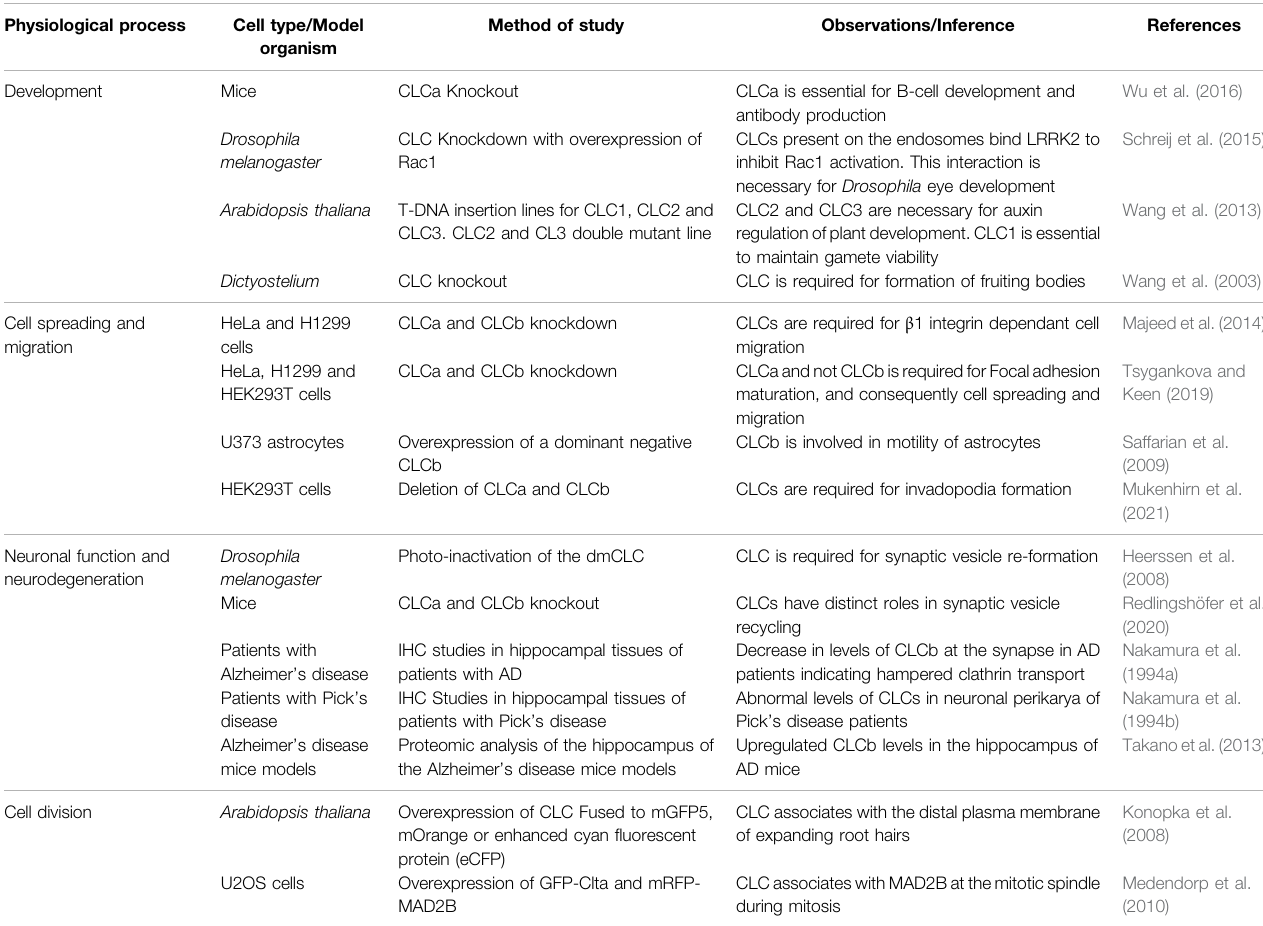
TABLE 1 | Table showing the role of clathrin light chains in various physiological processes. Physiological